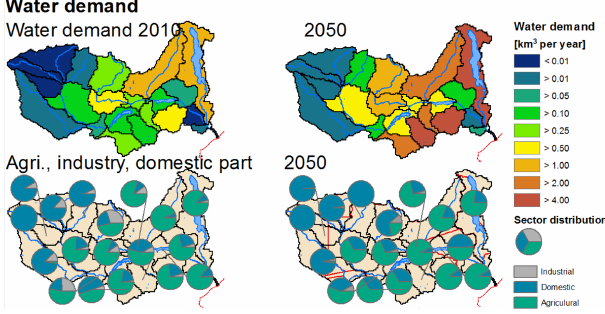
Figure 13. Water demand projection for scenario SSP2/RCP6.0 to 2050 based on population, GDP, and irrigation area